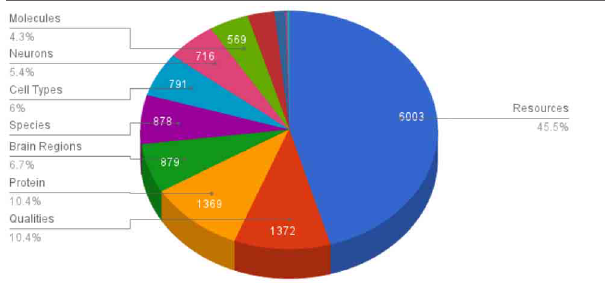
installed on Amazon EC2 (http://neurolex.org/wiki/Reasoning_ With_SPARQL_1.1). We then utilized SPARQL 1.1 (http://www .